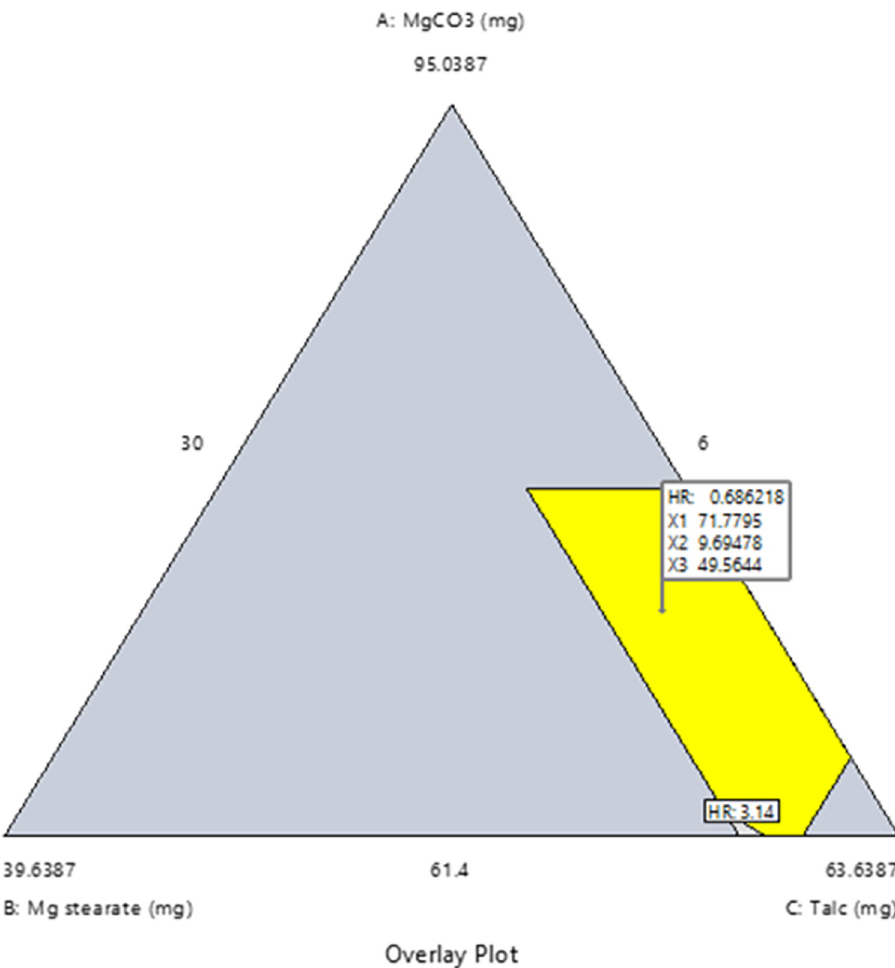
Fig 3. Overlay plot for optimal levels of excipients in a capsule formulation. The overlay plot illustrates the design space of the effects of magnesium carbonate (A = X 1 ), magnesium stearate (B = X 2 ), talc (C = X 3 ) at a fixed level of sodium bicarbonate (G) of 12.3613, and 76% of active pharmaceutical ingredients (MCFE and AEFE) on flowability measured by Hausner’s ratio. The yellow areas (design space) indicate the region where excellent flowability can be obtained.